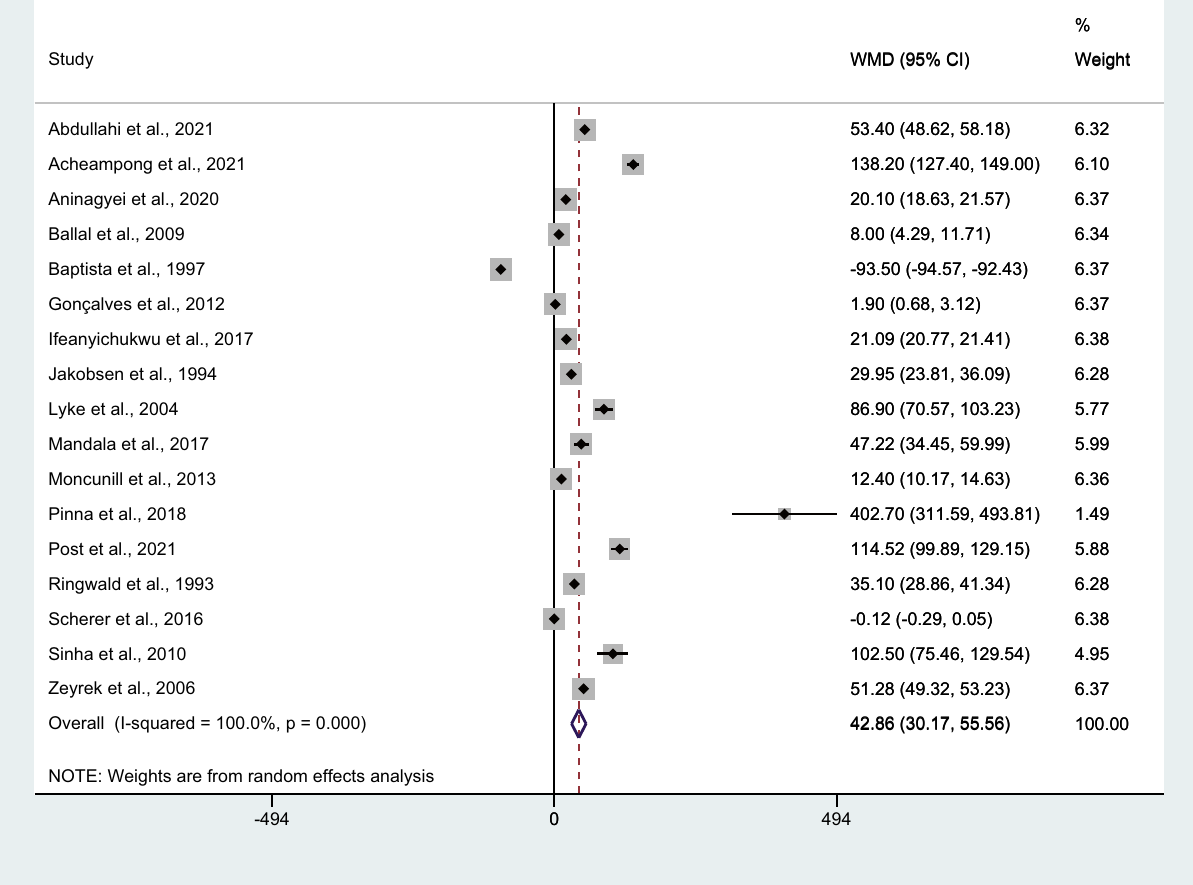
Figure 7. Differences in IL-6 levels between patients with uncomplicated malaria and controls. Abbreviation: WMD, weighted mean difference; CI, confidence interval; black diamond symbol, point estimate; solid line in the middle of the graph at 0, zero effect size; Dashed red line: pooled WMD between the two groups; I 2 , level of heterogeneity; P = 0.000 or less than 0.05, significant